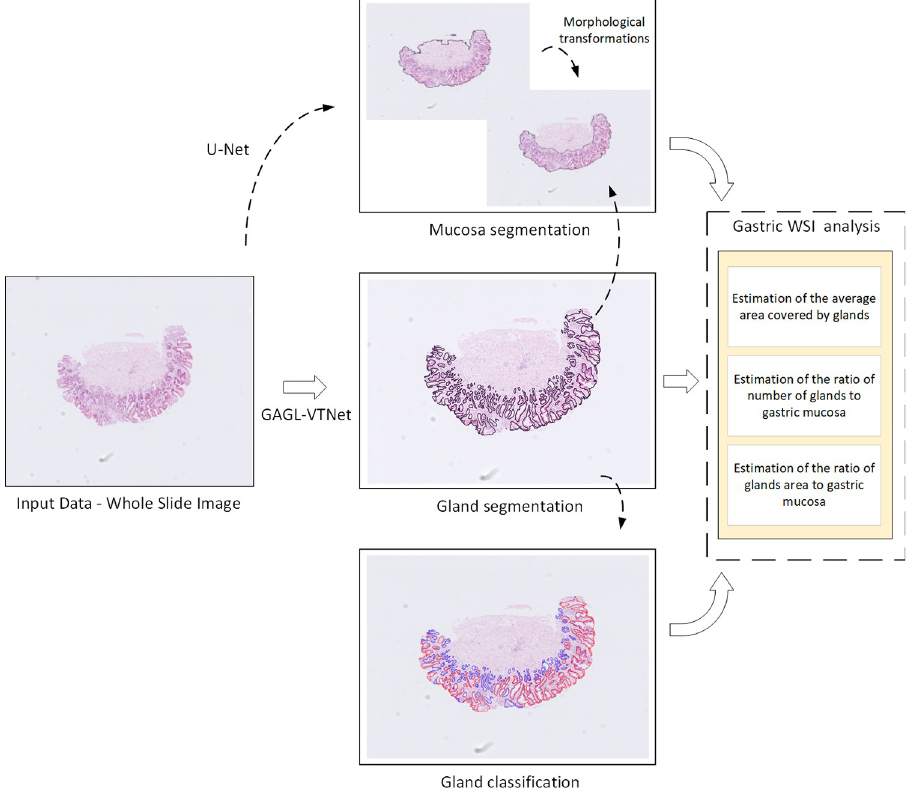
Fig 1. The proposed framework for gastric gland segmentation, classification and gastric WSI